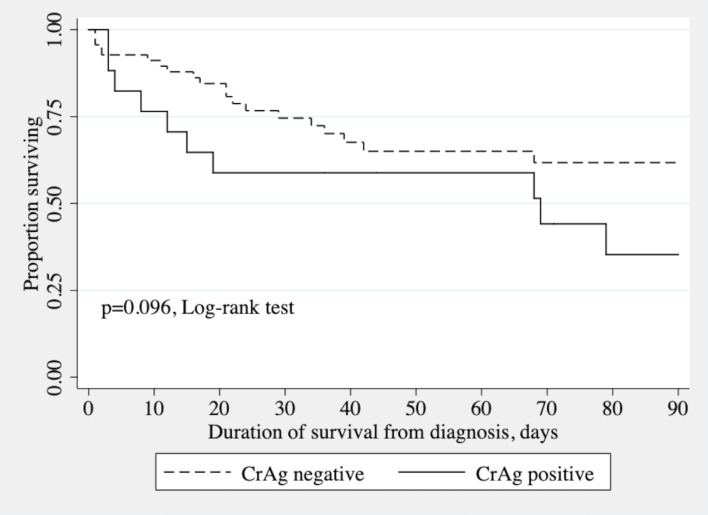
Kaplan-Meier survival curves for patients positive and negative for CrAg in tests on serum.